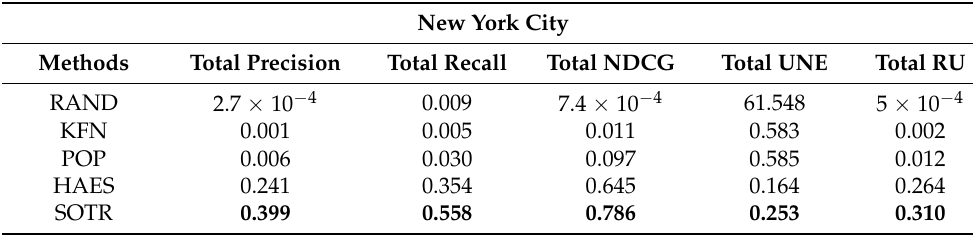
Table 4. Represents the experimental results for New York